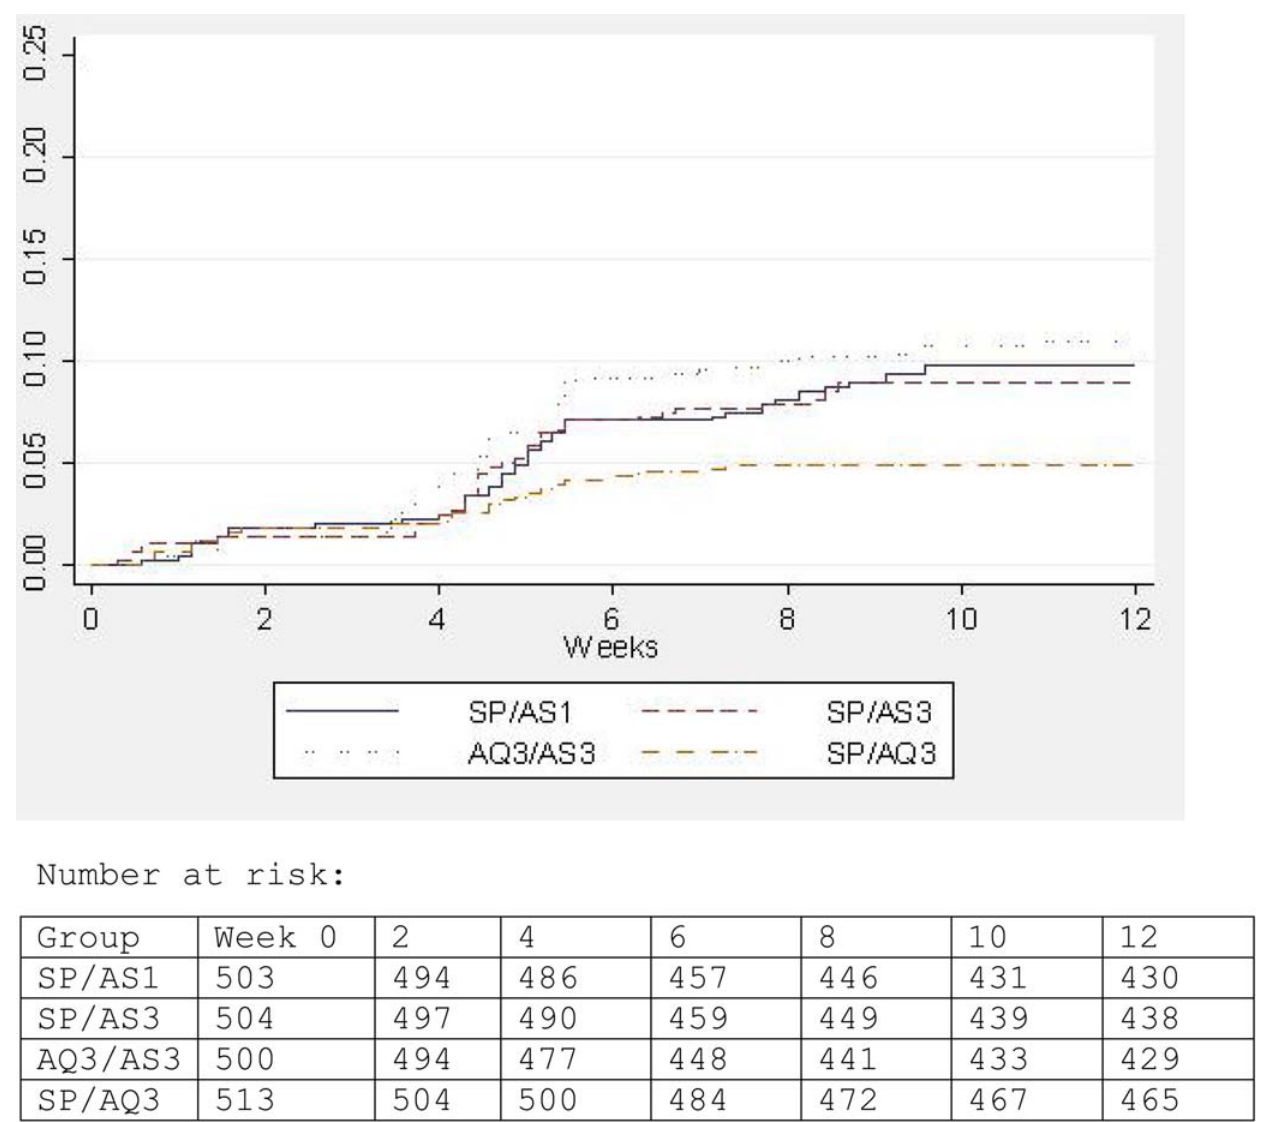
Figure 2. Kaplan Meier estimate of the cumulative incidence of malaria during the 3 months of follow-up.